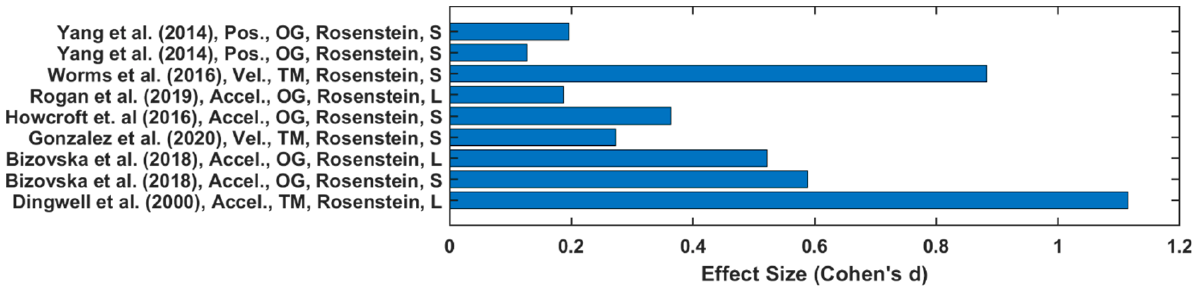
Figure 5. Effect size of LyE between healthy and fall-prone older adults’ groups.